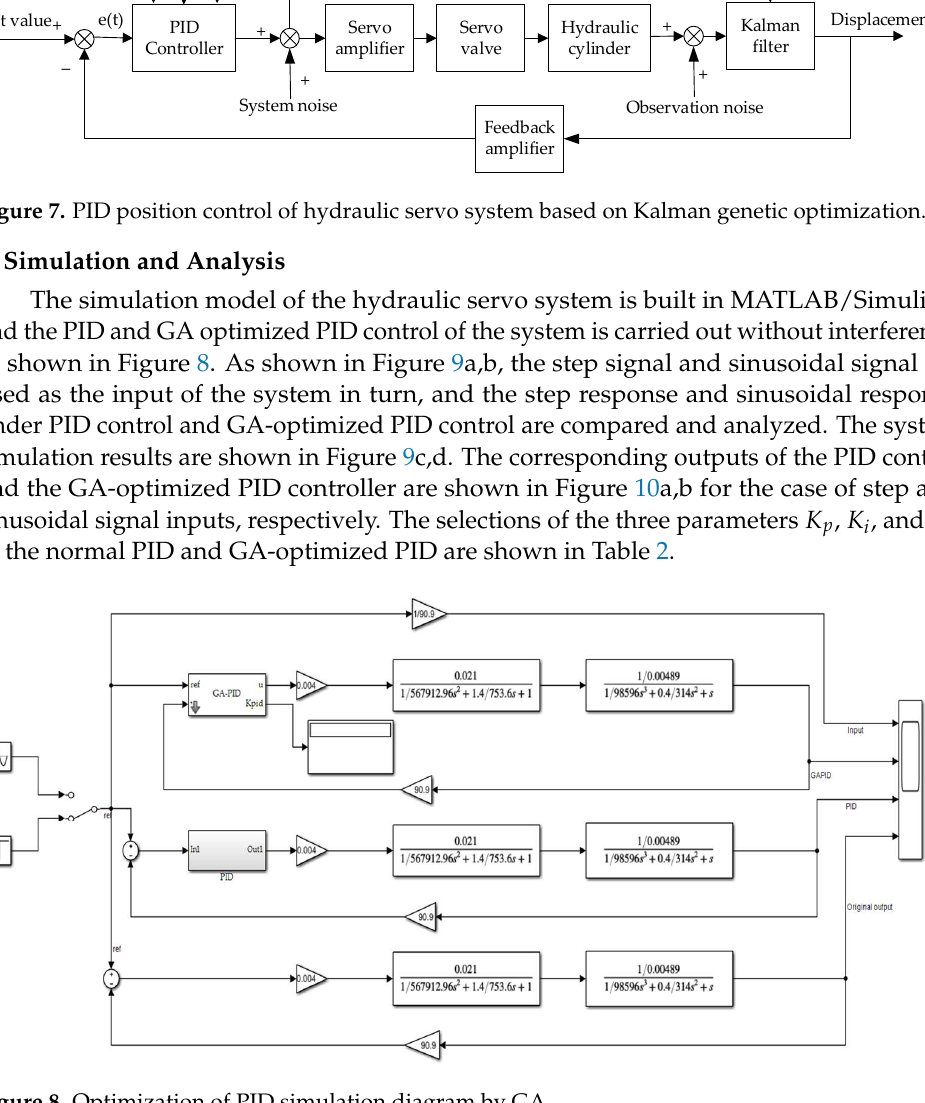
( d ) Figure 9. Simulation results of the system without noise. ( a ) Step signal input; ( b ) Sinusoidal signal; ( c ) System simulation results under step signal input; ( d ) System simulation results under sinusoidal signal input.